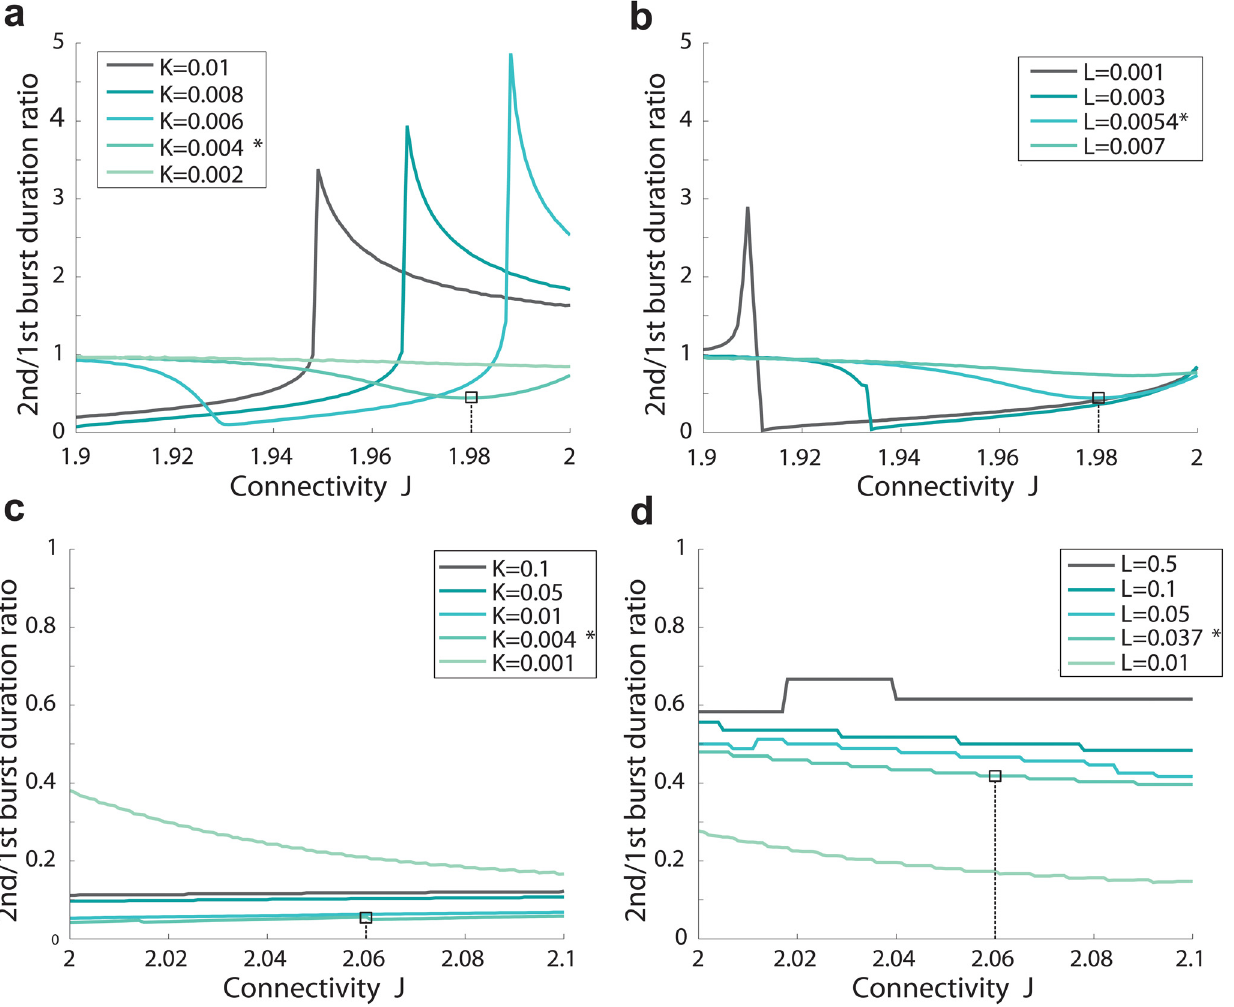
Fig 9. Ratio(2 nd /1 st ) of Reverberation duration time as a function of the synaptic connectivity. (A) Culture (B) Slices.